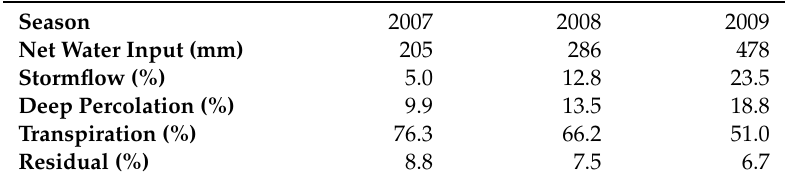
Figure 6. Cumulative travel time distributions of stormflow, deep percolation and transpiration, together with the aggregate travel time distributions for growing seasons 2007, 2008, and 2009. Table 4. Mass fractions of tracer relative to applied mass. Net water input is rainfall minus actual transpiration.